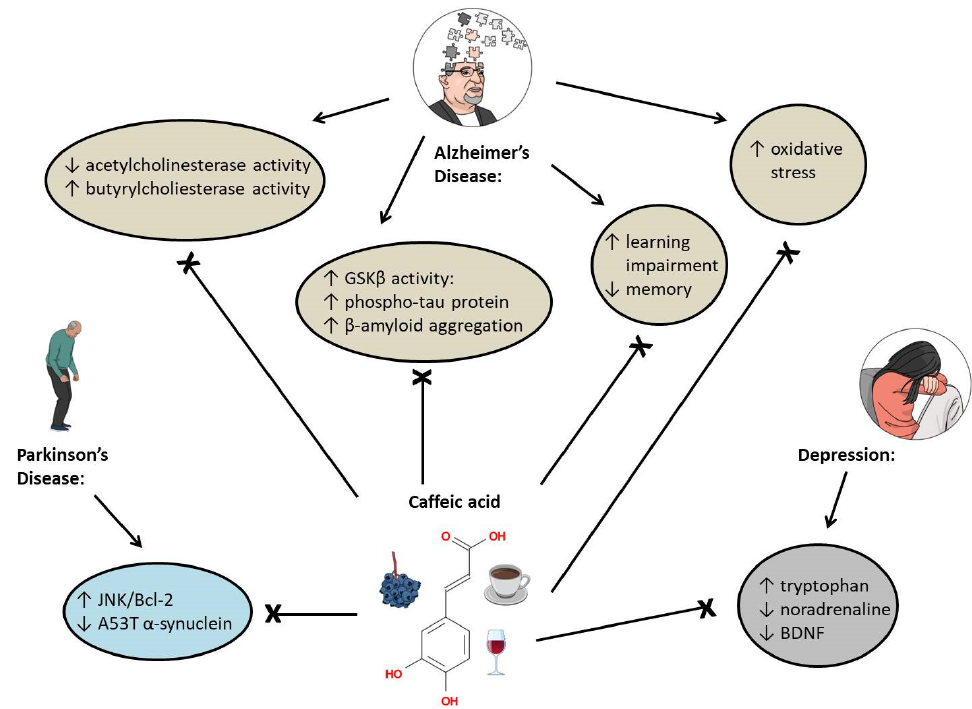
Figure 4. The effects of caffeic acid on brain-related diseases. GSK β means glycogen synthase kinase 3 β , A53T is a type of mutation, and BDNF means brain-derived neurotrophic factor.